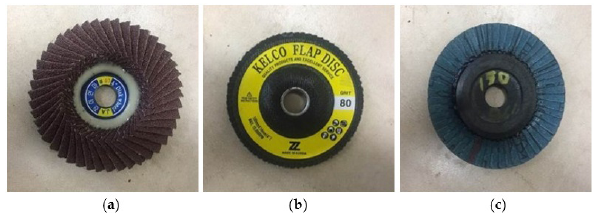
Figure 3. Various types of grinder blades: (a) grit 40, (b) grit 80 and (c) grit 150.